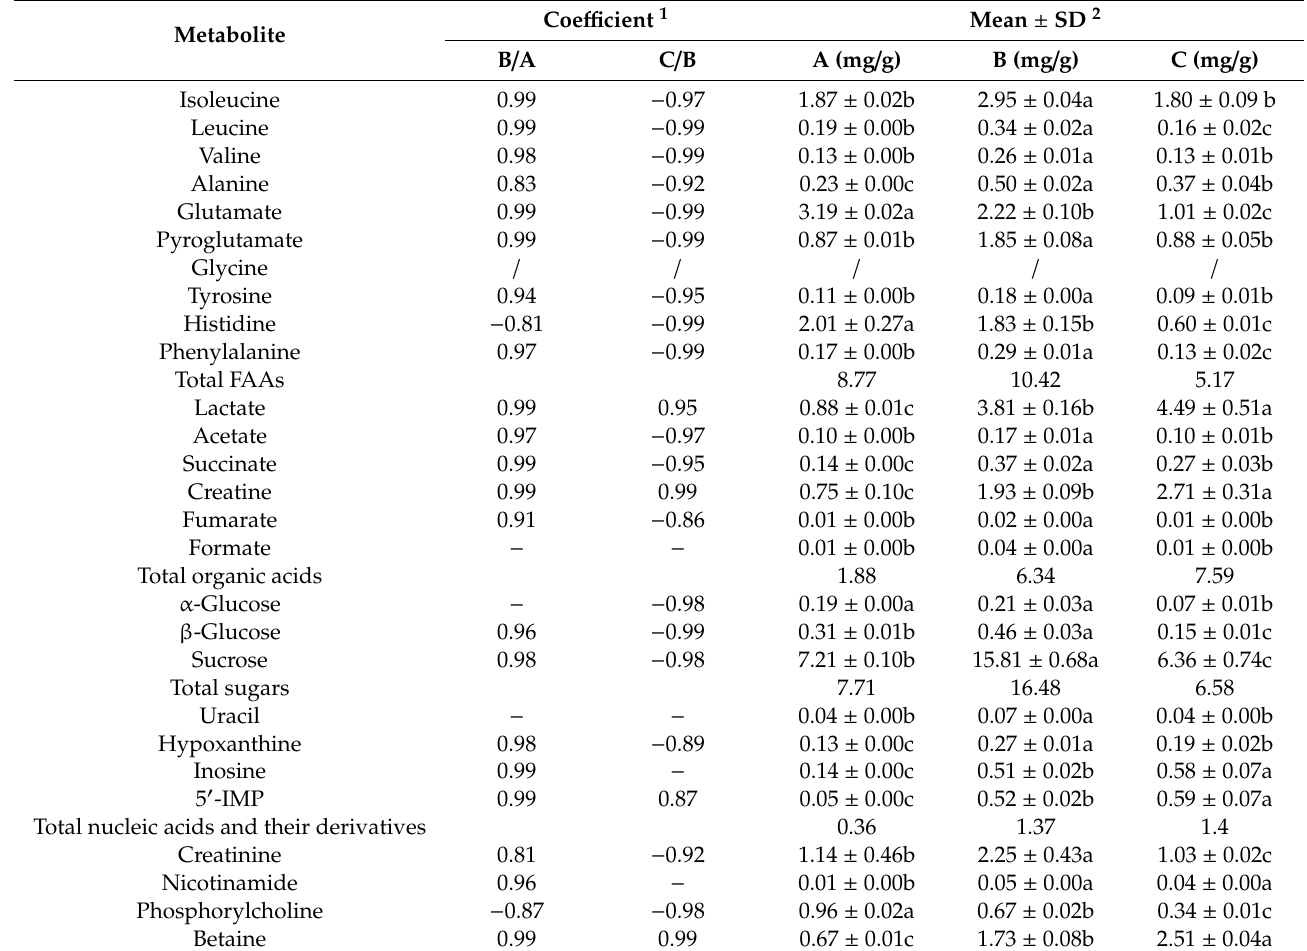
Table 2. Coe ffi cients from OPLS-DA and the contents of the taste-active